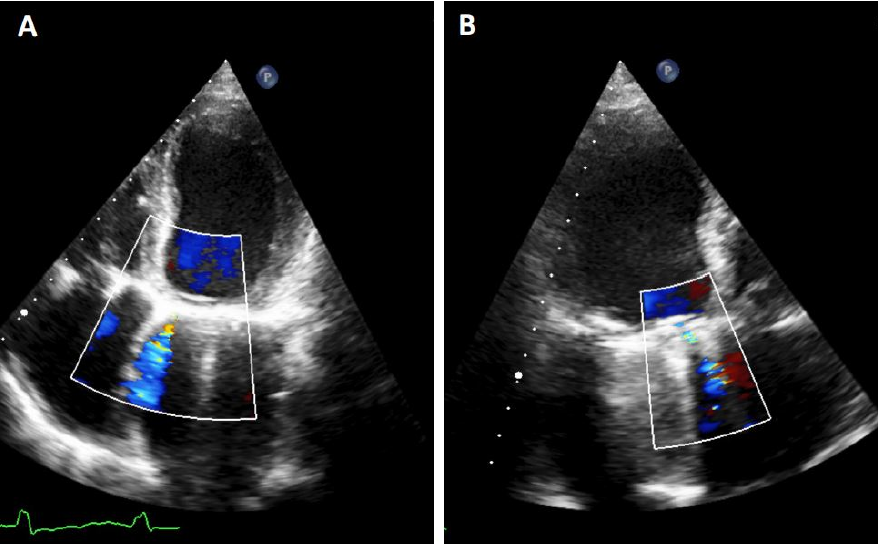
Figure 2. TTE PVL. Mitral regurgitation is detected. It must be noted that it is difficult to quantify the exact proportion of the flow in both planes due to artifacts as acoustic shadow. ( A ): 4-chamber image showing a mitral PVL with colour Doppler. ( B ): 3-chamber with acustic shadoiw in the left atrium and an anterior regurgigant jet of a PVL leak.